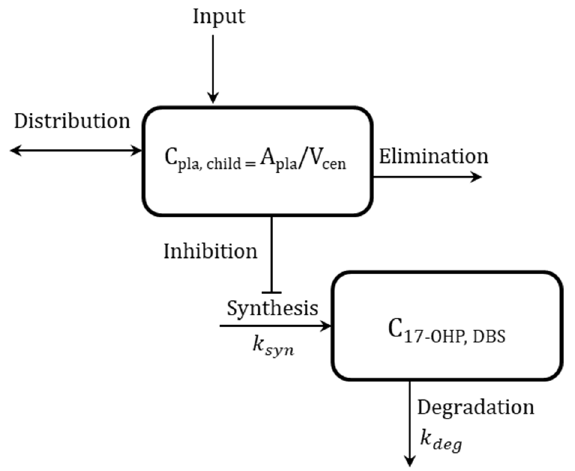
Figure 4. Simplified schematic representation of developed pharmacokinetic/pharmacodynamic (PK/PD) model for cortisol (top box)-mediated inhibition of synthesis of 17 α -hydroxyprogesterone (17-OHP; bottom box). Pediatric cortisol concentration in plasma (C pla, child ), pediatric cortisol amount (A pla ), central volume of distribution (V cen ), 17-OHP concentration in dried blood spots (C 17-OHP, DBS ), synthesis rate constant of 17-OHP (k syn ), and first-order degradation rate constant of 17-OHP (k deg ). For the full model scheme of the developed PK/PD model, see Supplementary Material. The maximum inhibitory effect (I max ) was pre-defined as 1 (=100% inhibition), and the Hill Factor (Hill) was fixed to 1 after obtaining estimates close to 1 (Table 1). The synthesis rate constant k syn was defined as the product of the estimated first-order degradation rate constant (k deg ) and the DBS 17-OHP concentration at baseline (17-OHP BASE ). The cortisol concentration inhibiting 50% of the maximum inhibitory effect (IC 50 ) was estimated to be 21 nmol/L with a high estimated interindividual variability (IIV on IC 50 = 104%CV), which was not explained by any covariate present in the dataset, such as body weight, corticosteroid-binding globulin (CBG) or albumin. Relative standard errors of the estimated model parameters were low, except for IIV on IC 50 (53%). Table 1. Parameter estimates of developed pharmacokinetic/pharmacodynamic (PK/PD) model for cortisol (drug) and 17 α -hydroxyprogesterone (biomarker) concentrations in young children and infants. Parameter